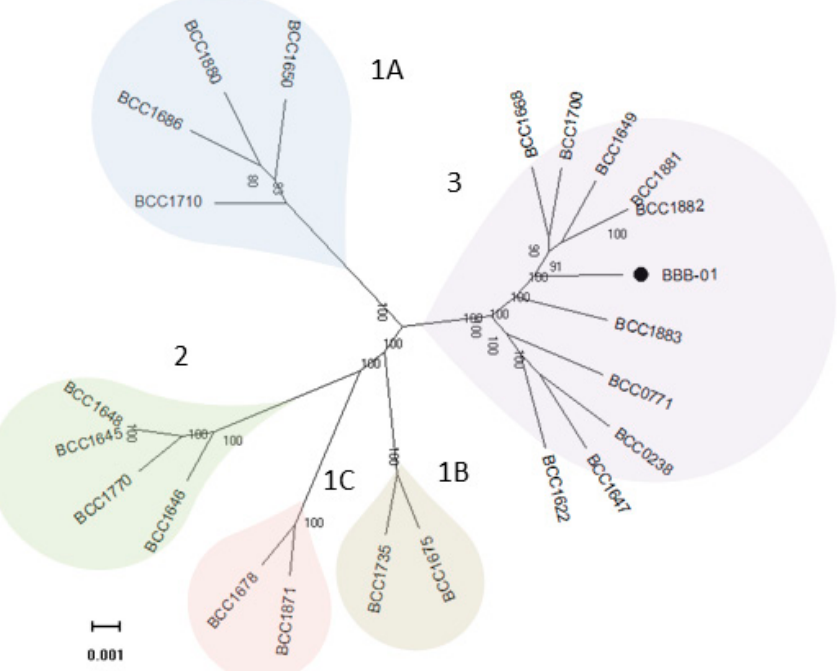
Figure 3. Phylogenetic relationship of 23 B. gladioli strains. The genomes of 22 previously reported B. gladioli strains and the strain isolated in this study (BBB-01) were analyzed and compared on the genome scale, from which 4141 core genes were identified. The concatenated core genes were aligned and used to construct a maximum-likelihood tree with 1000 rapid bootstraps. All the bioinformatics tools used in the construction of this phylogeny are described in Section 4. The scale bar represents the number of base substitutions per site.